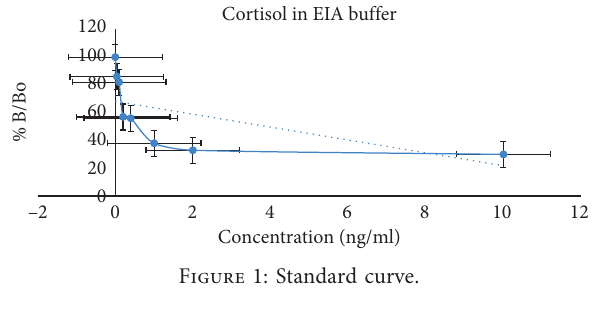
Figure 1: Standard curve.